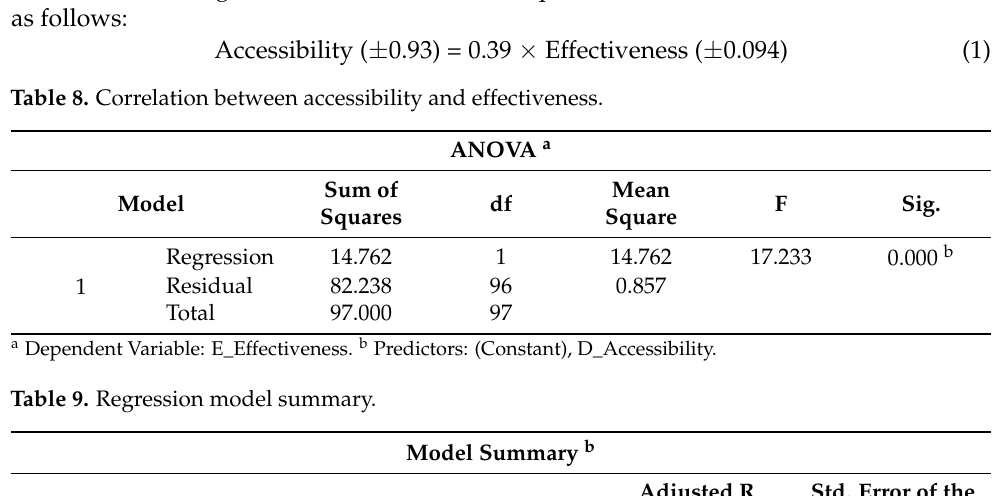
Table 8. Correlation between accessibility and effectiveness.